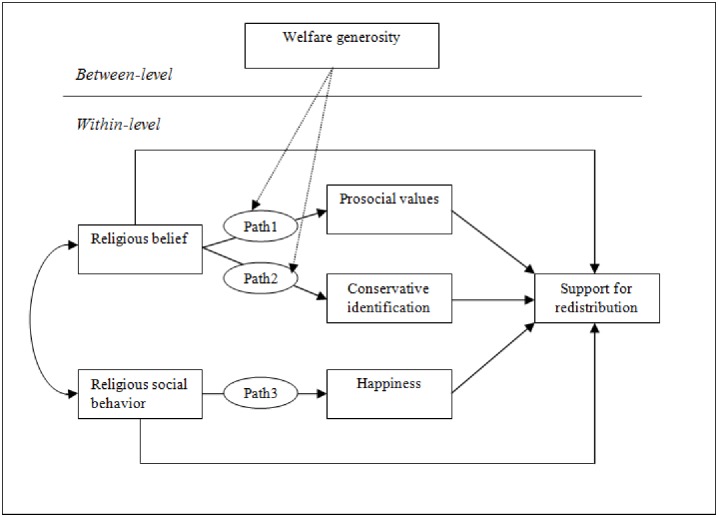
The proposed model.